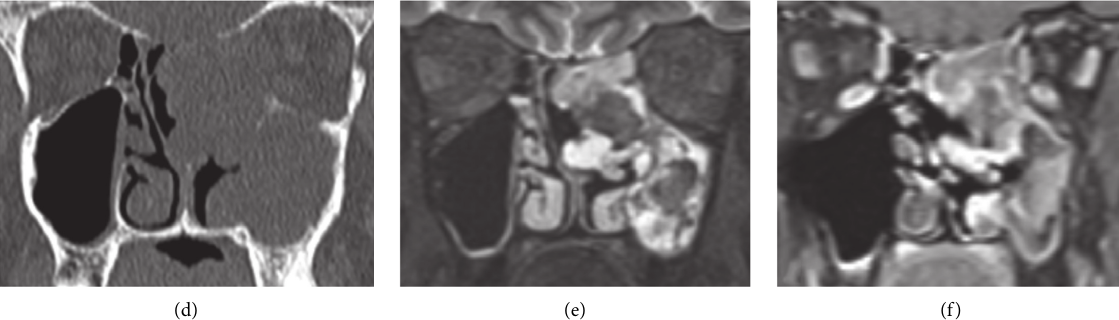
Figure 6: Diffuse large B-cell lymphoma in a 60-year-old male with a 4-month history of nasal blockage not responding to antibiotics. (a) Coronal unenhanced CT shows left sinonasal opacification with thinned medial maxillary sinus wall and destroyed middle turbinate. (b) Coronal STIR demonstrates a left nasal cavity lesion obstructing the maxillary sinus, which is hypointense to mucosa with heterogenous enhancement on (c) contrast-enhanced T1W. The left cribriform plate appears thinned and focally dehiscent on unenhanced CT (d); however, (e) STIR and (f) contrast-enhanced T1W show the skull base and medial orbital wall are